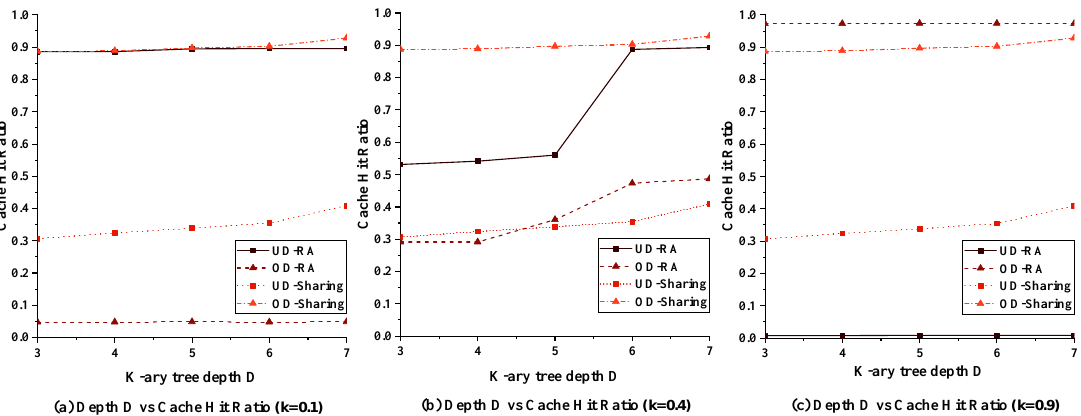
Figure 7. Caching performance vs. tree depth in terms of cache hit ratio when varying k